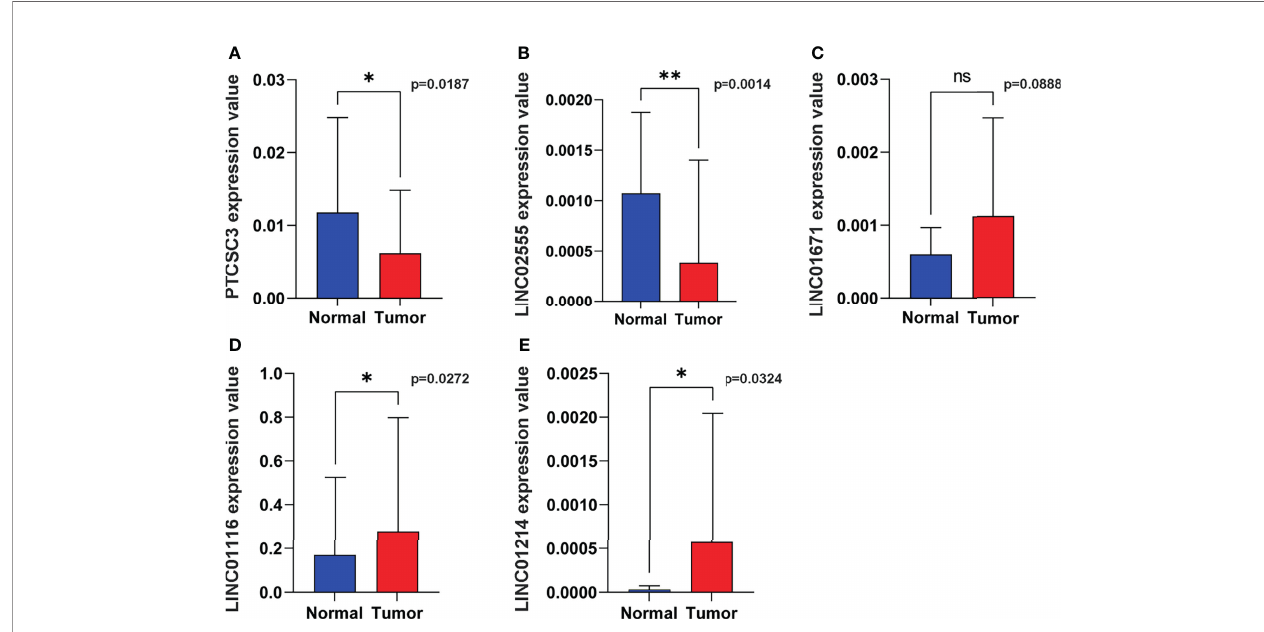
FIGURE 10 | Representative lncRNAs expression in tumor and normal tissues. (A) PTCSC3; (B) LINC02555; (C) , LINC01671; (D) LINC01116; (E) LINC01214. *P < 0.05; **P < 0.01; ns, P <